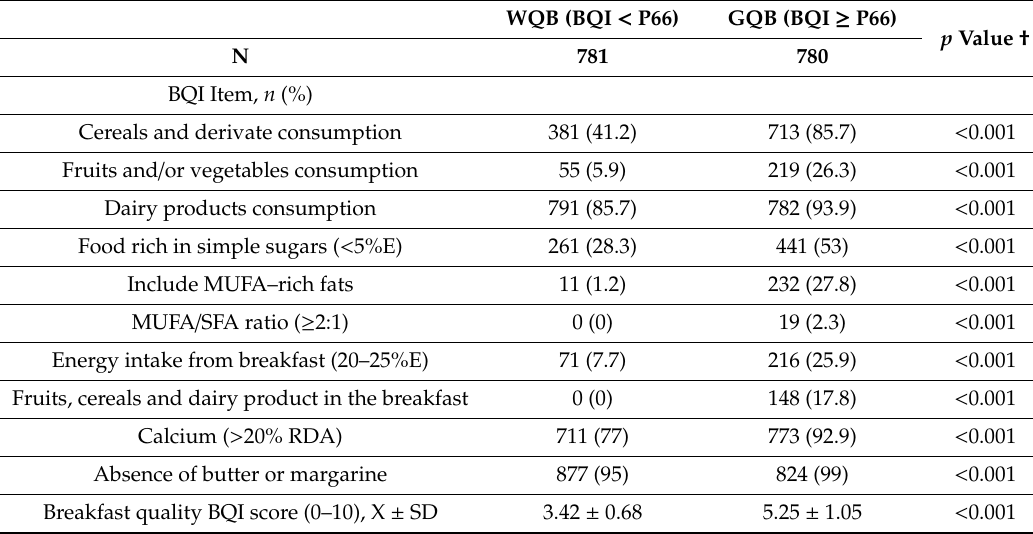
Table 5. Breakfast Quality Index (BQI) components and number of children meeting the criteria ( n , %) by quality breakfast